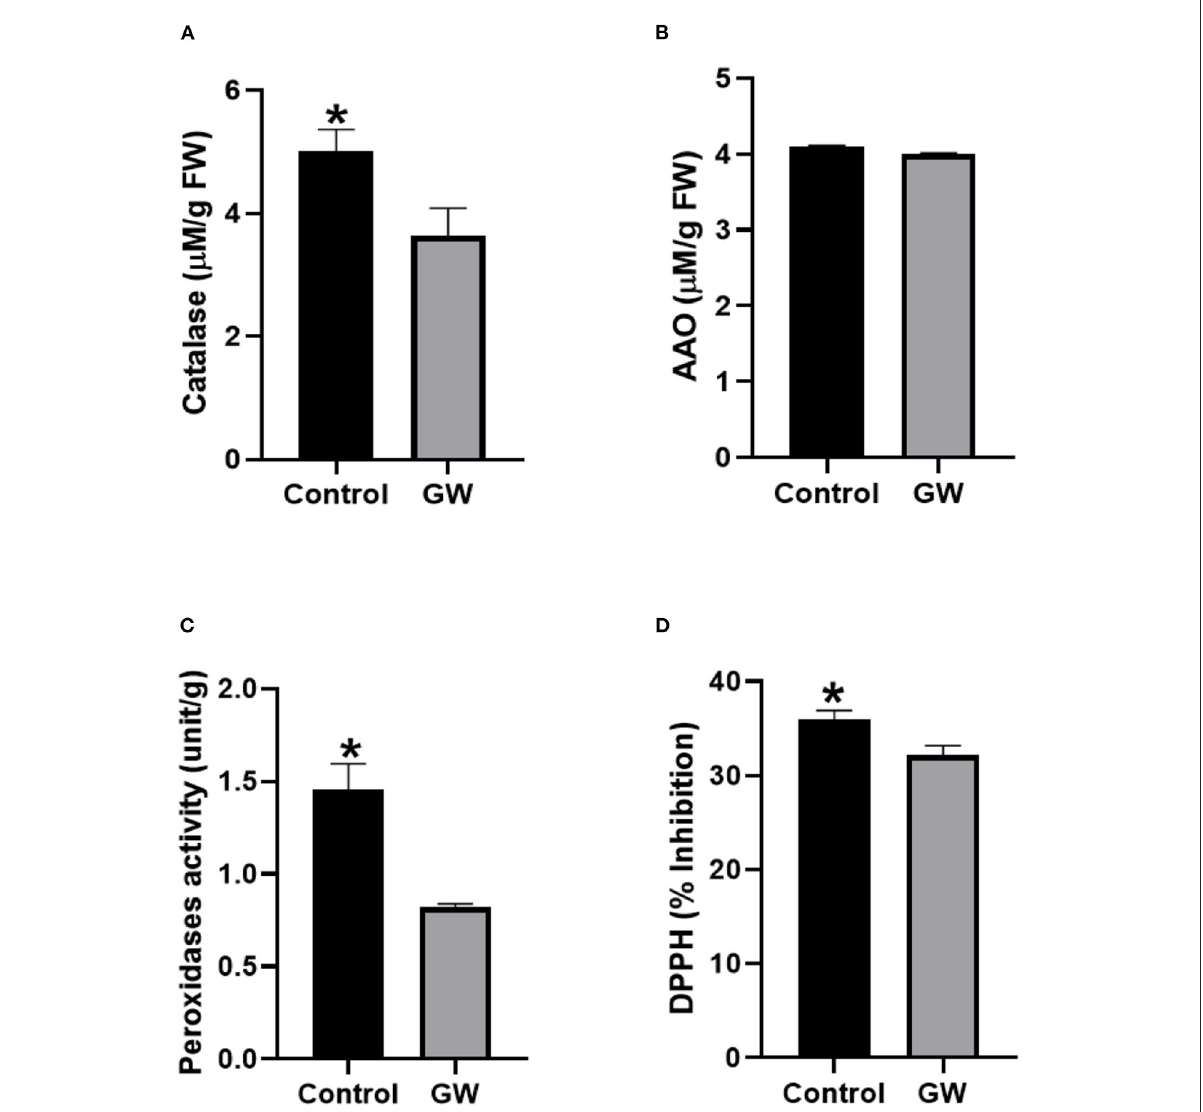
FIGURE8 Activities of antioxidant enzymes including (A) catalase, (B) AAO, (C) PO, and (D) percent inhibition of DPPH (ROS scavenging assay) in the leaf extract of A. fatua seedlings. Bars show the mean of three replicates with standard deviation. Bars labeled with * are significantly higher ( t -test; p <